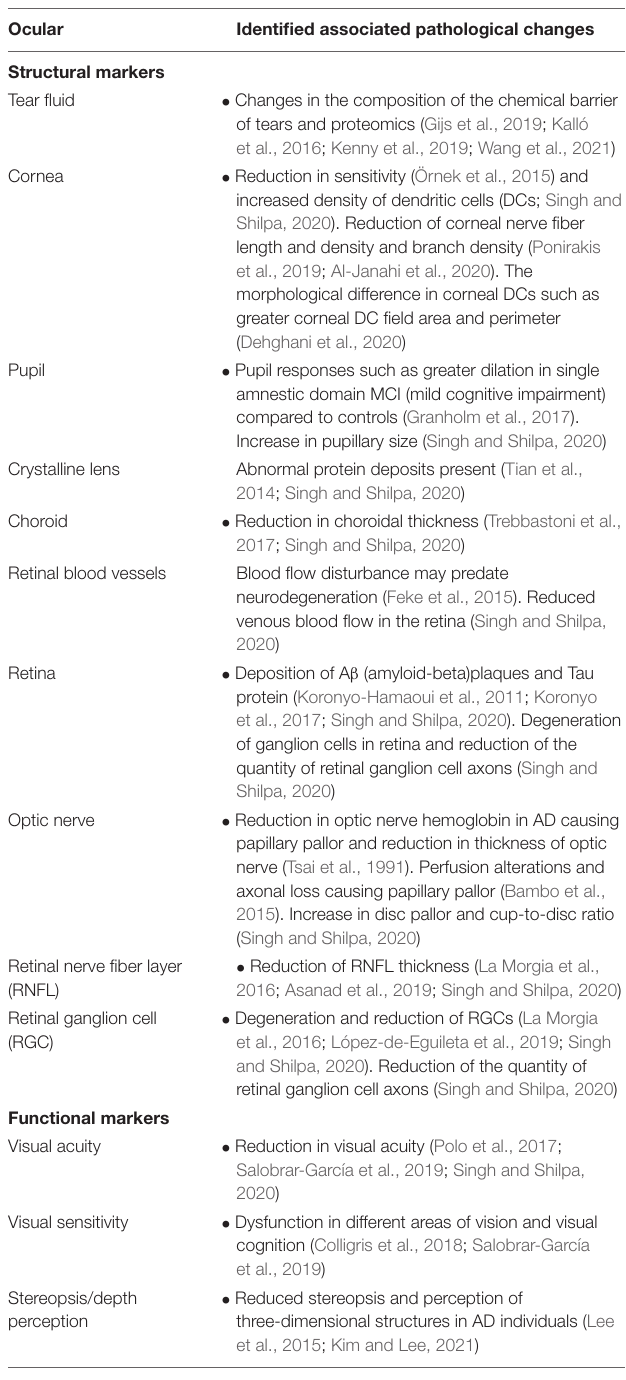
TABLE 1 | Ocular structures and their associated pathological changes in Alzheimer’s